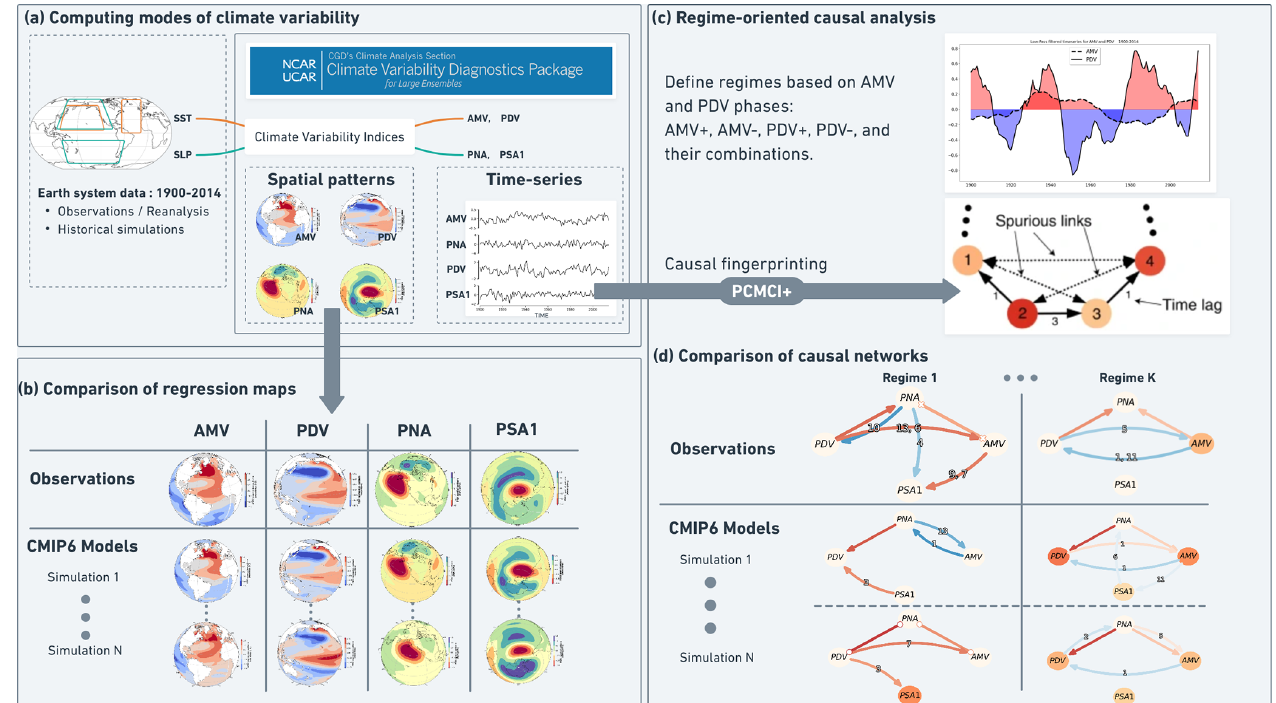
Figure 1. Framework for the regime-oriented causal model evaluation. (a) Gridded SST and SLP data used to calculate indices for AMV, PDV, PNA and PSA1 modes of climate variability. Diagnostics from the NCAR Climate Variability Diagnostic Package for large ensembles (CVDP-LE) produce the time series of these indices and their associated spatial patterns (regression maps). (b) We first, as a sanity check, compare the CMIP6 model-simulated SST (for AMV and PDV) and SLP (for PNA, PSA1) regression maps to those from reanalysis be- fore (c) using the time series of the four indices for the regime-oriented causal analysis. Here, we define different regimes depending on the sign of the 13-year low-pass-filtered AMV and 11-year low-pass-filtered PDV time series. For every regime, we run PCMCI + to estimate instantaneous and lagged links between nodes representing the time series of the indices calculated in (a) from the reanalyses and model data. In this schematic example, there are four indices, with node color indicating auto-correlation, and there is a causal link (solid black arrow) between index 2 and indices 1 and 3, and then there is a causal link between indices 3 and 4. The method identifies and removes spurious links (see dashed black arrows) between indices 1 and 4 or between indices 2 and 4. Unitless representative time lags are labeled on each causal link, where index 1 lags index 2 by one time step (depending on the temporal resolution of the time series – here, it is yearly), index 3 lags index 2 by three time steps, and index 4 lags index 3 by one time step. Applying the method to the time series in (a) provides (d) dataset- and regime-specific causal fingerprints in a similar format to the schematic in (c) , which can be used for model evaluation and inter- comparison. We calculate annual averages from the monthly time series of PDV and AMV provided by CVDP-LE. This way, the data frame is fit for multi-year and decadal causal estimations. In addition to the subtraction of global mean temperatures in the CVDP-LE calculation of PDV and AMV, the causal networks are estimated after linearly detrending the time series of the four indices to ensure their stationarity. The estimated causal dependencies (links) are hence assumed to be a mixture of internal variability and time-varying anthropogenic forcing (mainly from